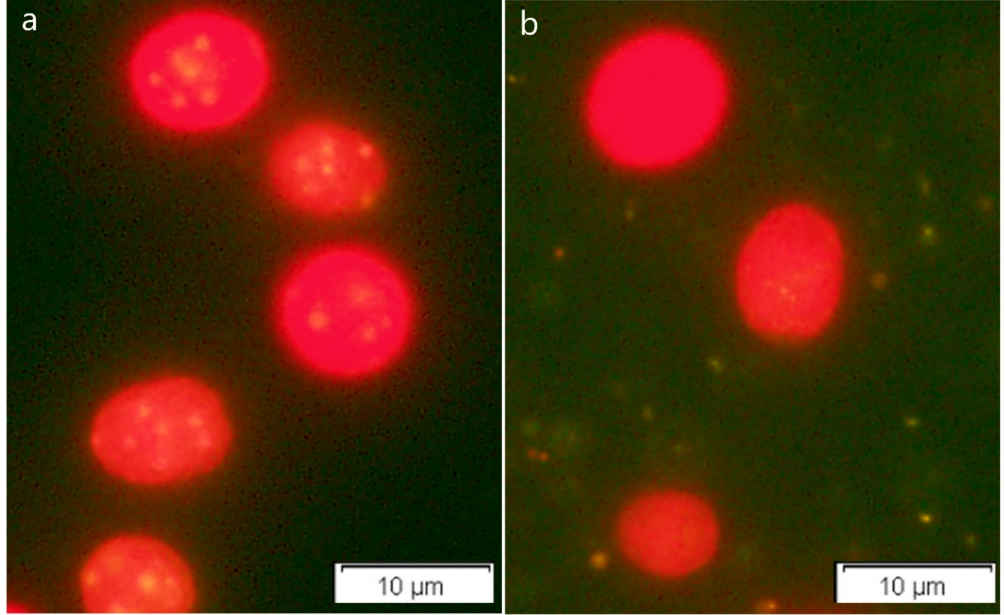
Figure 6. Nile Red staining lipid drops in C. reinhardtii under ( a ) salt stress and ( b ) the control treatments. The cell and lipid droplet colors were visualized with red and yellow, respectively, under fluorescent